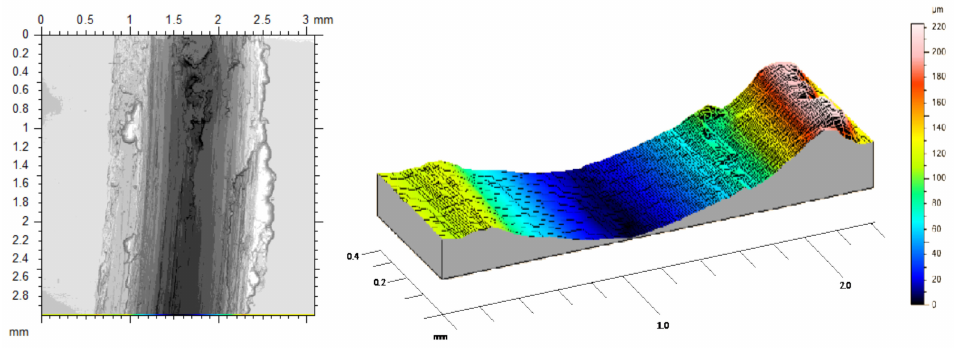
Figure 6. Third stage sliding track, with an adhered debris layer over the sliding way, and deposited material in the outer edges of the track.